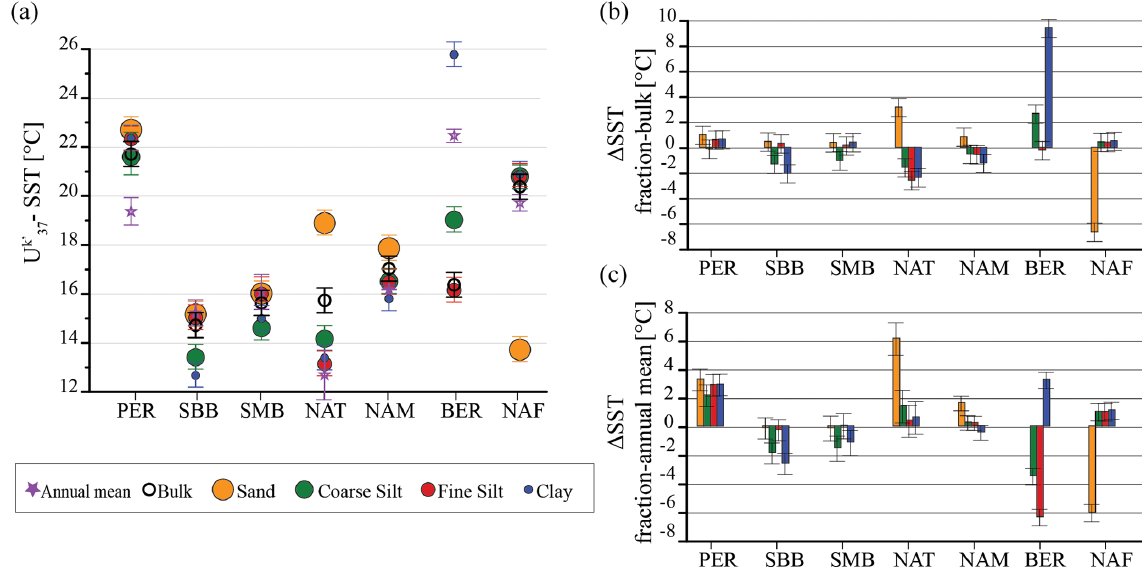
Figure 6. SST at each site. (a) Bulk SST, grain-size fraction and annual mean SST (Locarnini et al., 2019). Abundance-weighted average SST is indicated by black triangles. Temperature difference between (b) each grain-size fraction and bulk SST and (c) bulk and annual mean